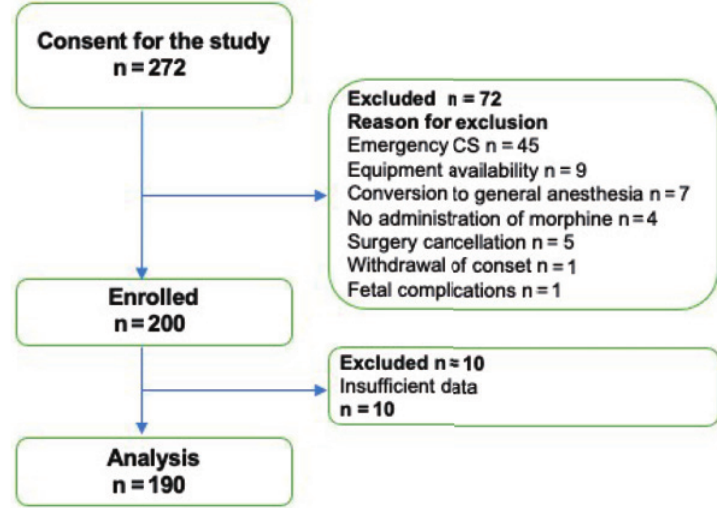
Figure 1. Flow diagram of participants through the study.